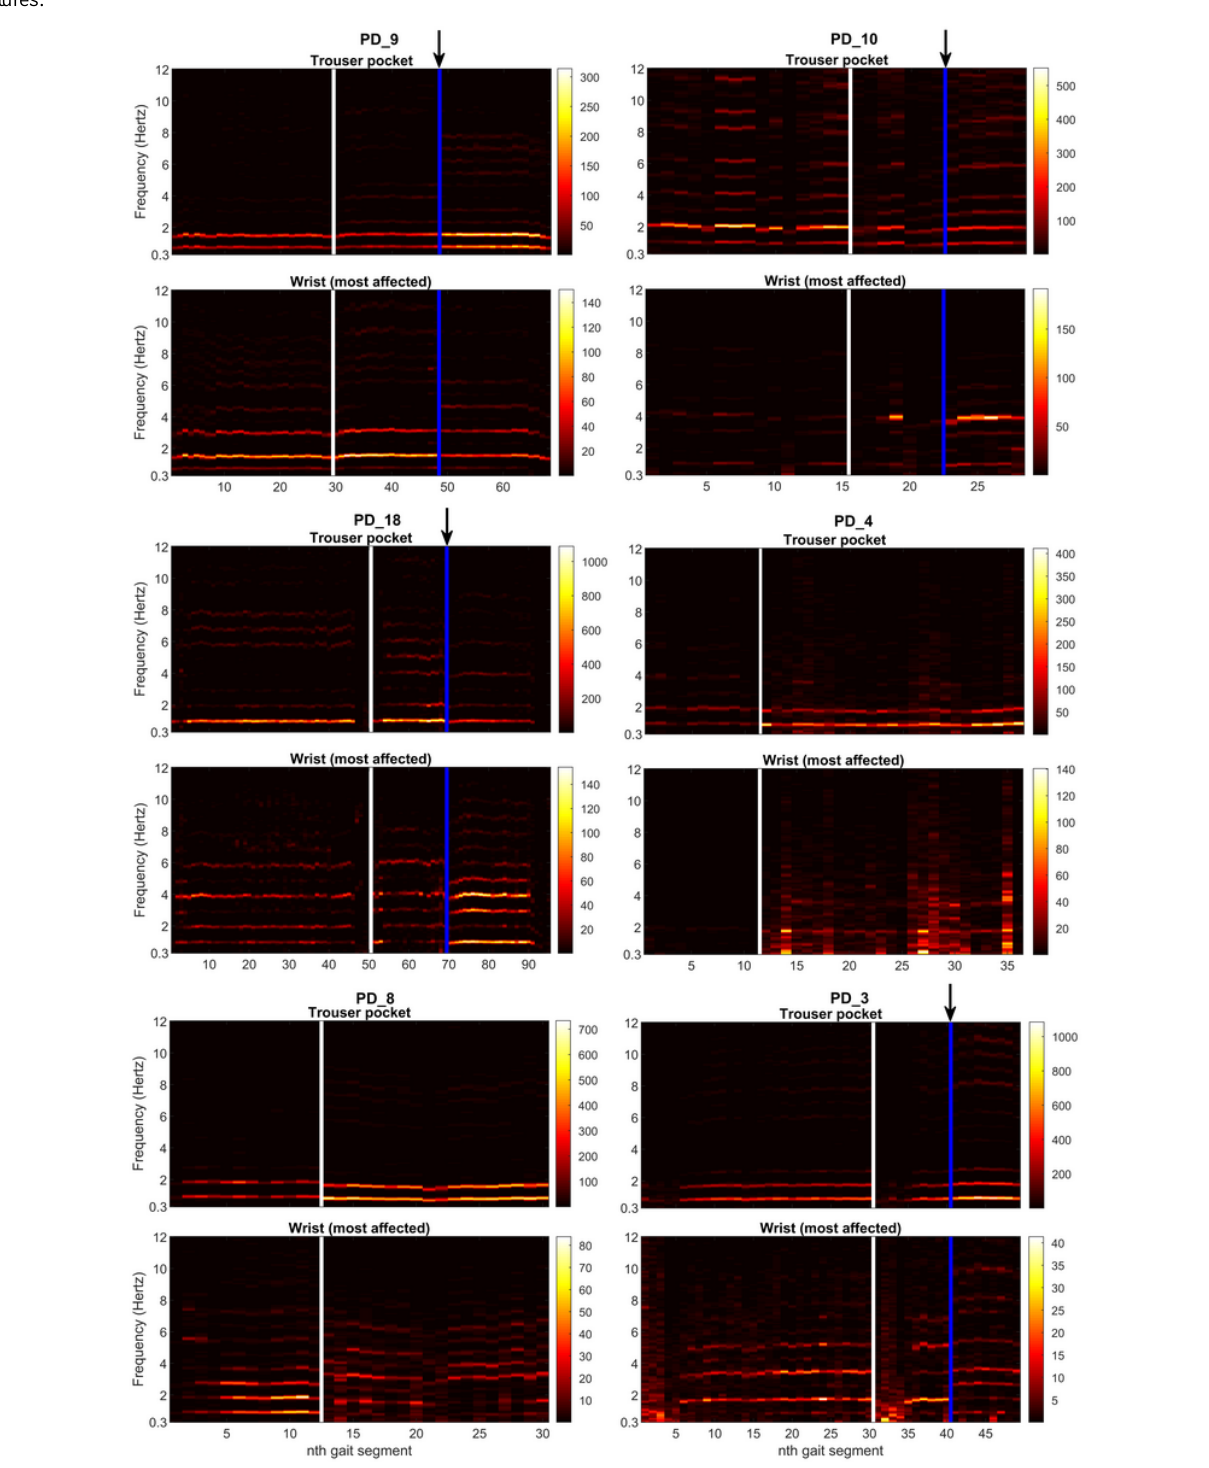
Figure 5. Visualization of the PSD of the devices worn on the wrist (most affected side) and in the pants pocket of 6 illustrative patients. x-axis: nth gait segment of 25 seconds (the white line indicates intake of dopaminergic medication). y-axis: frequency (hertz). Color bar: PSD in (m/s 2 ) 2 /Hz. PD_9: blue line with arrow indicates when patient moved his hand from his pants pocket to the pocket of his jacket (during the premedication part, his hand was in his pants pocket). PD_10: blue line with arrow indicates when patient removed her hand from the pocket of her jacket (during the premedication part, her hand was outside the pocket). PD_18: blue line with arrow indicates when patient put his hand in his pants pocket (during the premedication part, his hand was outside the pocket). PD_4: after medication intake, the patient presented with choreic dyskinesias in both arms and legs, which were most severe on his most affected side. PD_8: before medication intake, the arm swing on his most affected side was practically absent. After medication intake, he showed an arm swing with a small amplitude and started to make occasional gestures. PD_3: before medication intake, the arm swing on his most affected side was practically absent (hand was outside the pocket). After medication intake, first he had his hand in the pocket of his jacket. Blue line with arrow: patient removed his hand from the pocket and demonstrated an arm swing with a small amplitude, and he started to make occasional